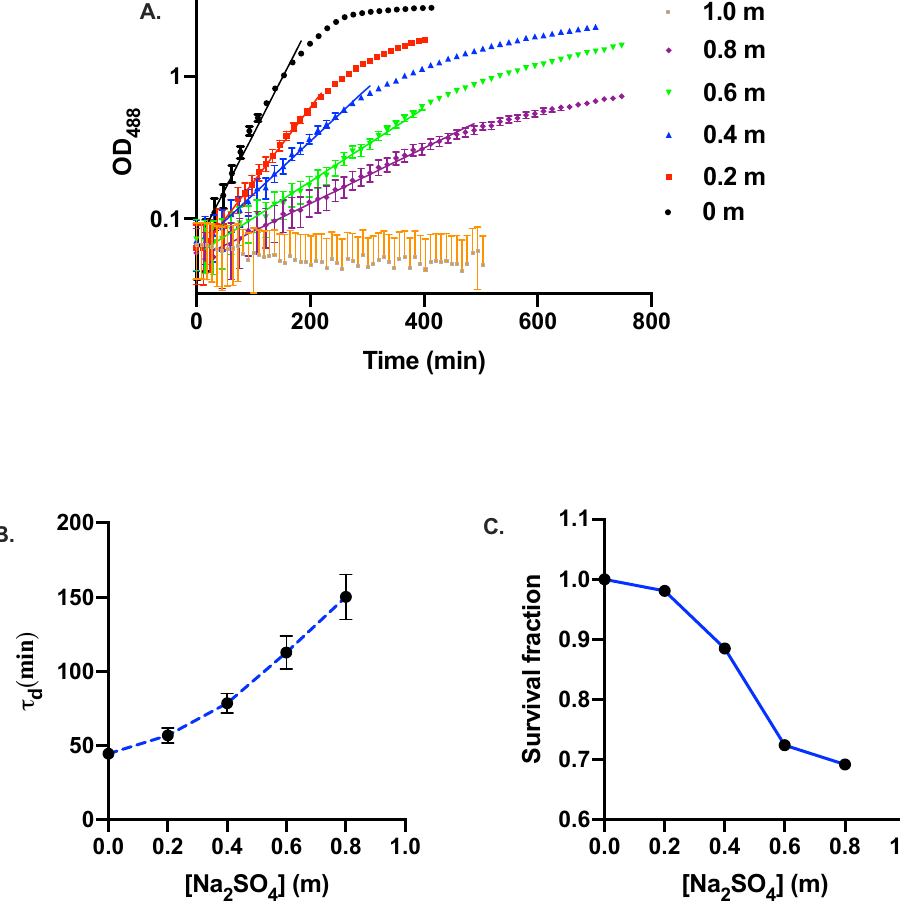
Figure 3. ( A ) Linear-log plot of the growth curves of E. coli at different concentrations of Na 2 SO 4 . ( B ) Biomass doubling time, τ d , of bacteria as a function of salt concentration. The biomass doubling time, τ d , is calculated by fitting exponential curves through the data points (shown as solid lines in A ) in the exponential growth phase. ( C ) Survival fraction of bacteria as a function of Na 2 SO 4